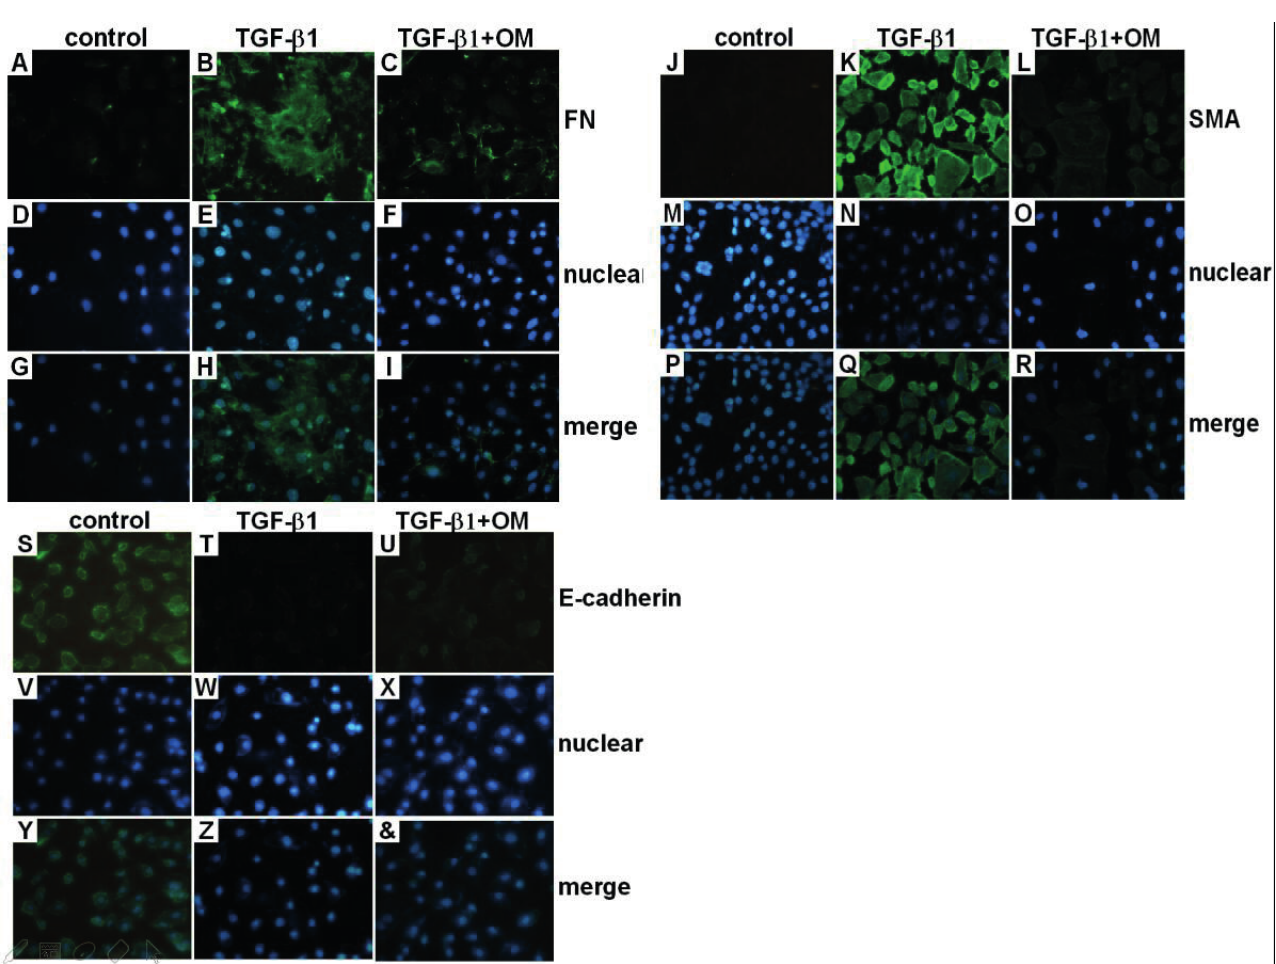
FIGURE 6 - Immunofluorescence staining demonstrated that OM blocks TGF- β 1-mediated EMT in HK-2 cells Immunofluor escent microscopy of FN (A through I), α -SMA (J through R) and E-cadherin (S through &) in HK-2 cells after various treatments. HK-2 cells were treated without (A, J, S) or with TGF- β 1 at 5 ng/mL (B, K, T), or TGF- β 1 plus 360 mg/L of OM (C, L, U) for 48 h. Basline FN (A, G), α -SMA (J, P) and E-cadherin (S, Y) in HK-2 cells. FN (B, H) and α -SMA